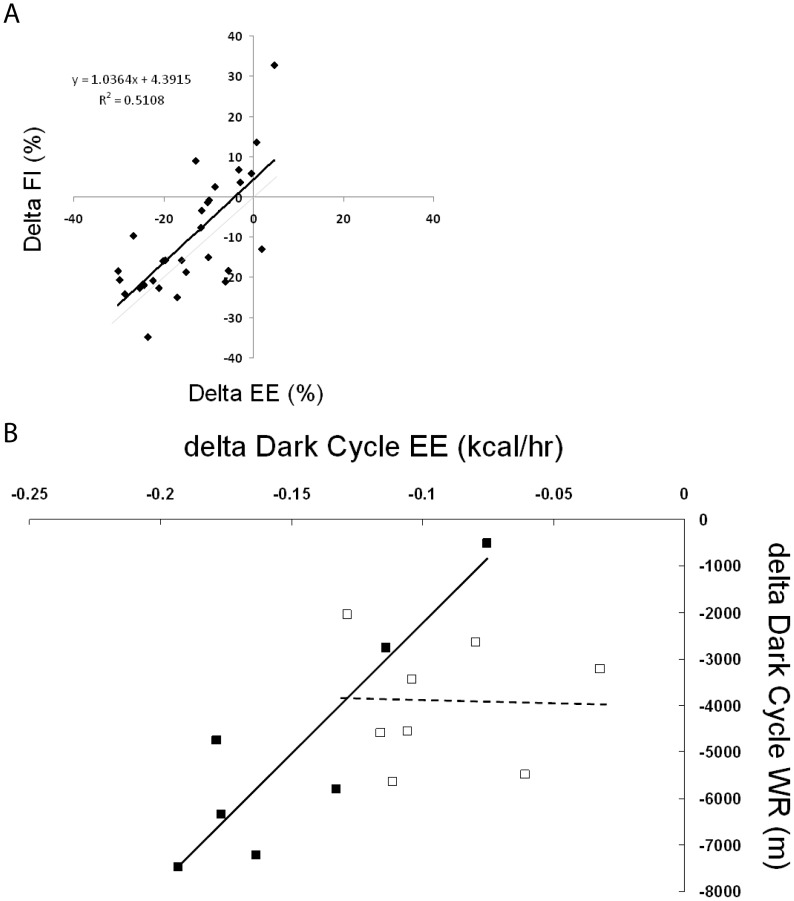
Correlation between change in energy expenditure (EE) and change in food intake (FI) or wheel running (WR) in individual mice.A Decrease in EE and FI for individual mice shown as % of value during the study period prior to the intervention (Baseline for Temp. change period (n = 15) and Exercise for the Sedentary period (n = 14). EE and FI data used were 3–4day averages for each distinct time period. Linear regression line (black) is parallel to line of identity (gray). B Decrease in dark cycle EE with exercise cessation vs. (negative) mean dark cycle WR distance during exercise period for mice housed at 21°C (open squares, dashed line) or 28°C (closed squares, solid line; note WR did not record for one mouse in the G28C group).